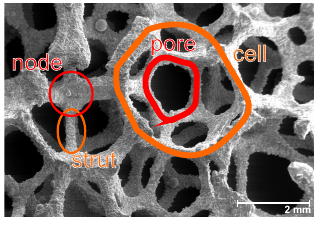
Figure 1. The structure of open-cell metal foam.